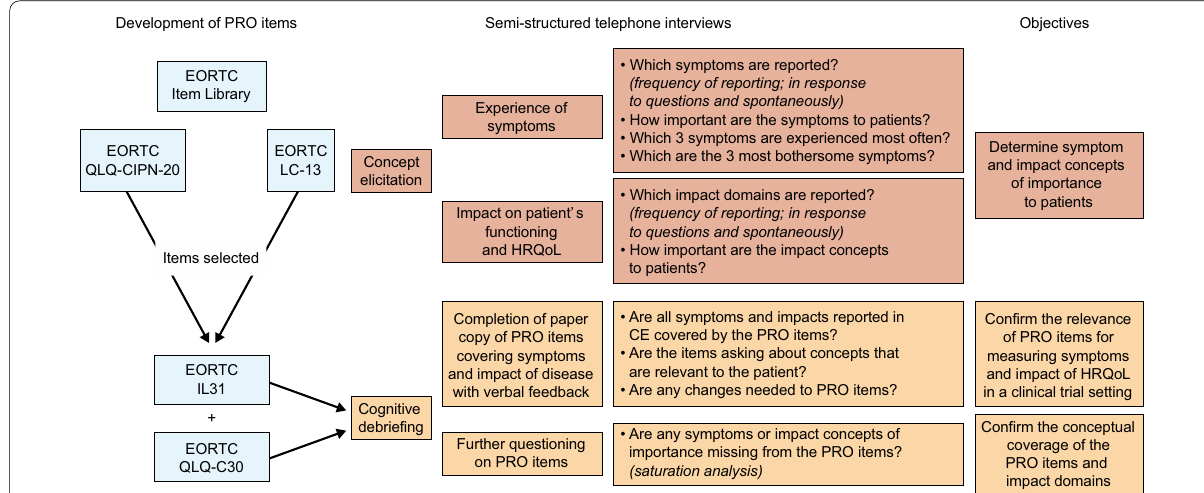
Fig. 1 Summary of Study Methods and Objectives. CE, concept elicitation; EORTC, European Organization for Research and Treatment of Cancer; HRQoL, health-related quality of life; IL31, Item Library 31; PRO, patient-reported outcomes; QLQ-C30, Quality of Life Questionnaire Core 30; QLQ-CIPN20, Quality of Life Questionnaire—Chemotherapy-Induced Peripheral Neuropathy 20-item